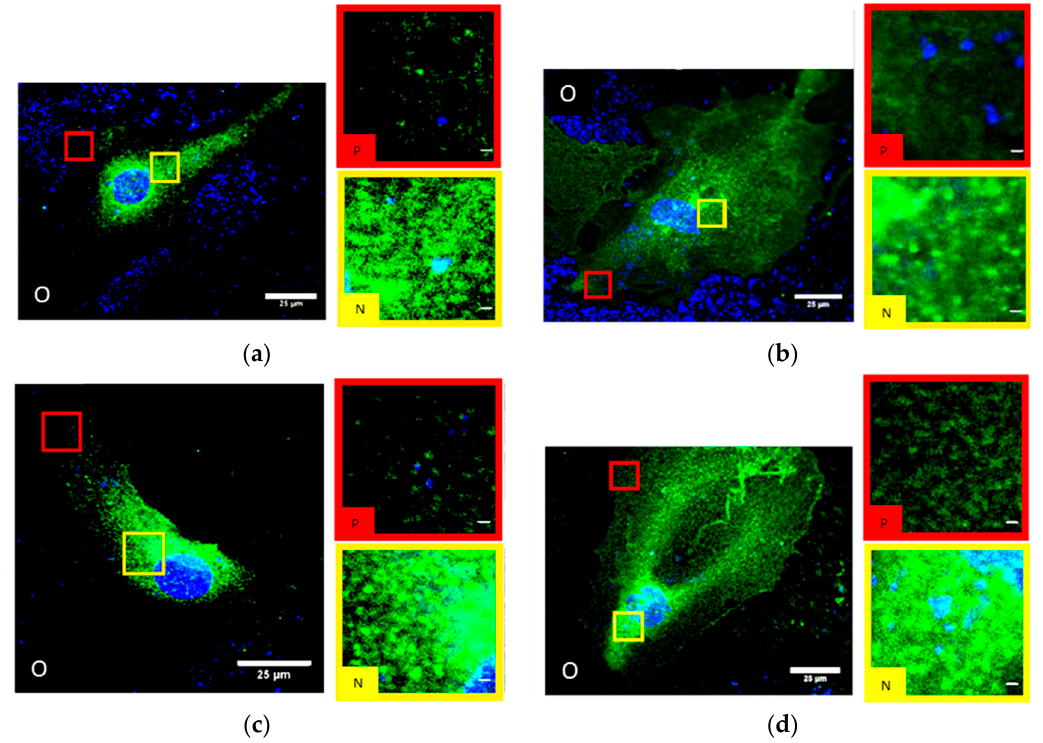
Figure 4. CLSM images of HIMAECs ( a ) untreated; ( b ) after 4 Gy irradiation and 50 min recovery; ( c ) after 1-hour NRG1 treatment; ( d ) after 1-hour trastuzumab treatment; blue: Cell nucleus after Hoechst34580 staining; green: Cx43 specific antibody labelling and Alexa488 staining. (O) Overview with selected peripheral and perinuclear regions. (P) Image section of the periphery of the cell. (N) Image section of the perinuclear region of the cell. Scale bar 1 µm.